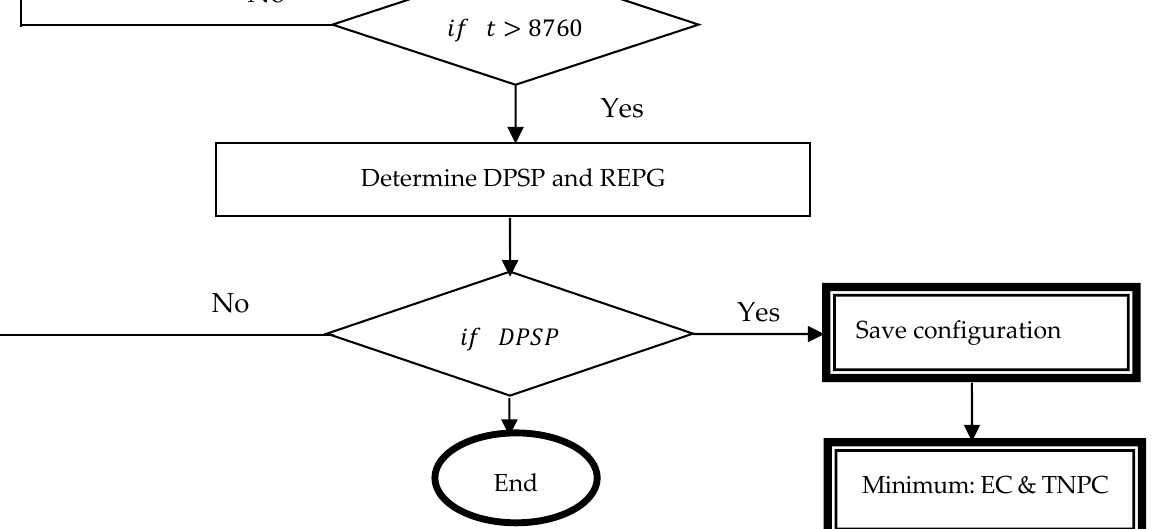
Table 1. System parameters.